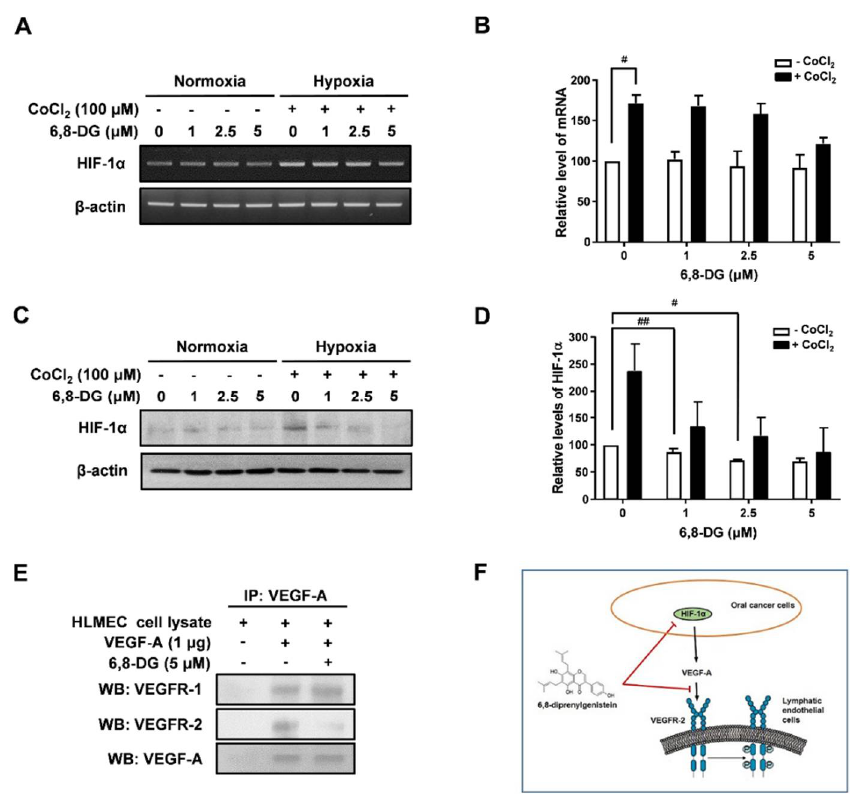
Figure 6. Effects of 6,8-DG Effect of 6,8-DG in oral cancer related lymphangiogenesis. ( A ) SCCVII cells were treated with different concentrations of 6,8-DG (0, 1, 2.5, 5 μM) in the presence or absence of 100 μM of CoCl 2 for 24 h. cDNAs were generated from total RNAs treated with DNase I, and PCR reaction was performed with specific primers of HIF-1α and β-actin. ( B ) PCR products from three independent experiments ( A ) were quantified and represented as a bar diagram. The levels of the VEGF-A and -C transcripts in the control (6,8-DG- and CoCl 2 -untreated cells) were estimated as 100%. ( C , D ) The cells were lysed and samples subjected to SDS-PAGE. Western blot was performed with anti-HIF-1α and anti-β-actin antibodies. ( E ) Total protein extracts of HLMECs were collected and analyzed by co-immunoprecipitation with rhVEGF-A and anti-VEGF-A antibody. The protein levels of VEGFR-1, VEGFR-2, and VEGF-A were detected by Western blot using anti-VEGFR-1, anti-VEGFR-2, and anti-VEGF-A antibodies. ( F ) Schematic illustration of the mechanism of action of 6,8-DG in oral cancer related lymphangiogenesis. Data are presented as a mean ± S.D. of three independent experiments ( # p < 0.01, ## p <